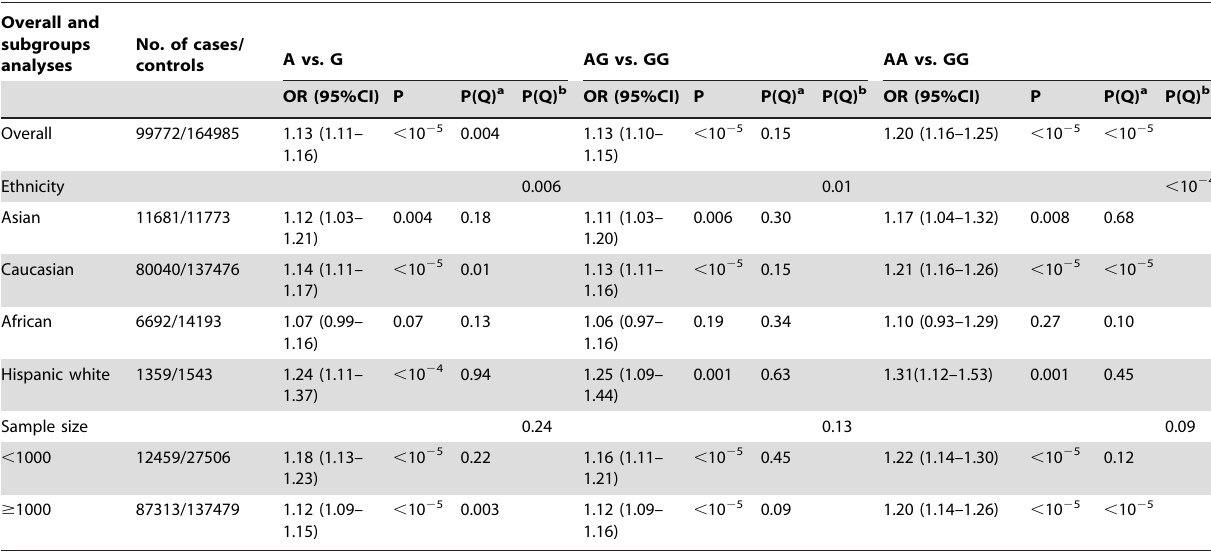
Table 2. Results of meta-analysis for 2q35-rs13387042 polymorphism and BC risk.